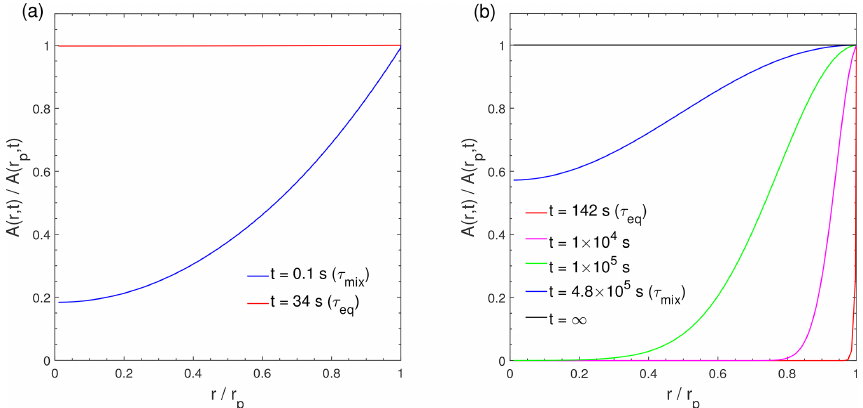
Figure 3. Dimensionless radial concentration profiles in the particle for the condensation of the LVOC species ( C 0 = 0 . 1µgm − 3 ) at RH = 60% and (a) T = 298K with D b = 10 − 11 cm 2 s − 1 and (b) T = 250K with D b = 10 − 18 cm 2 s − 1 . The x axis indicates the radial distance from the particle center ( r ) normalized by the particle radius ( r p ), ranging from the particle core ( r/r p ≈ 0) to the surface ( r/r p = 1). The y axis indicates the bulk concentration of the condensing compound at a given position in the bulk ( r ) normalized by the bulk concen- tration at particle surface ( r p